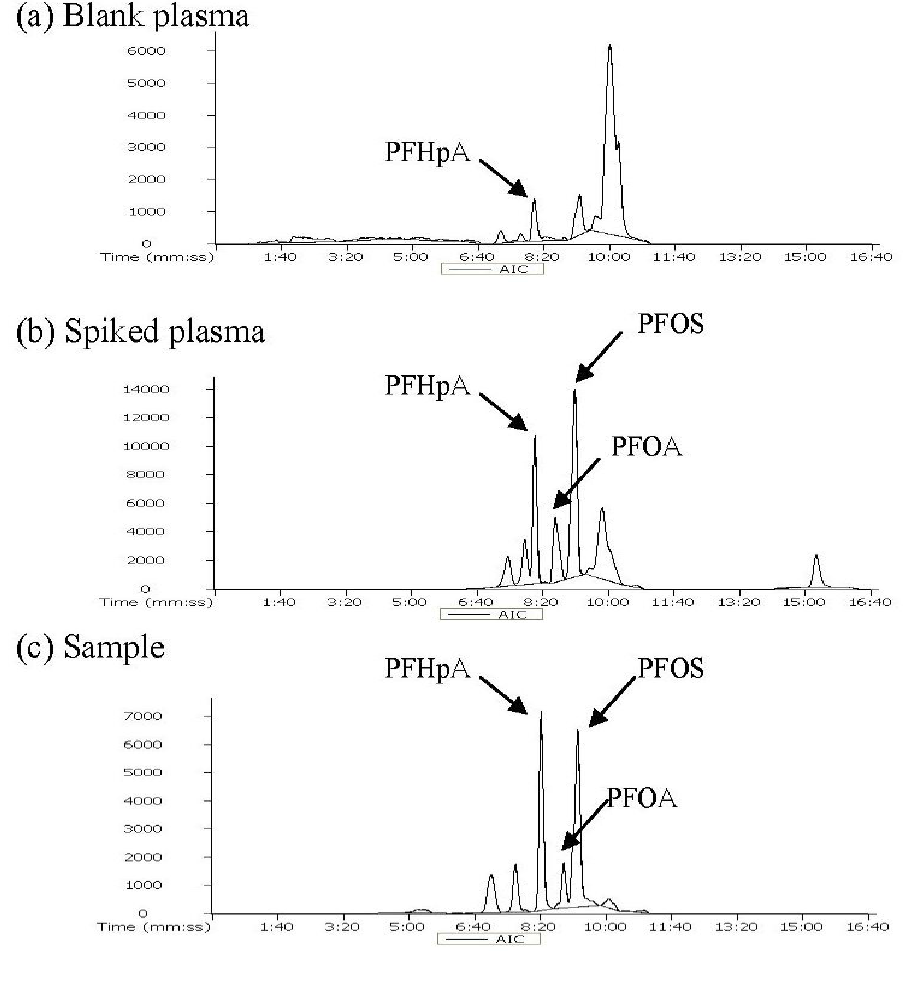
Figure 1. Adjusted ion chromatograms of PFOS and PFOA in ( a ) blank plasma; ( b ) spiked plasma and ( c ) sample by LC/ESI/TOF/MS.